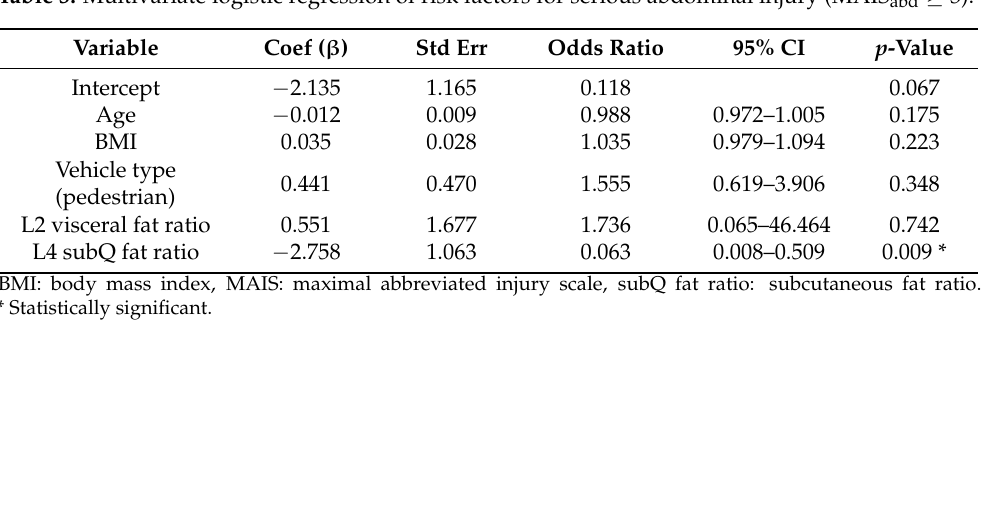
BMI: body mass index, GCS: Glasgow coma scale, ISS: injury severity score, MAIS: maximal abbreviated injury scale, subQ fat ratio: subcutaneous fat ratio, LOS: length of hospital stay, ICU LOS: length of ICU stay; a mean